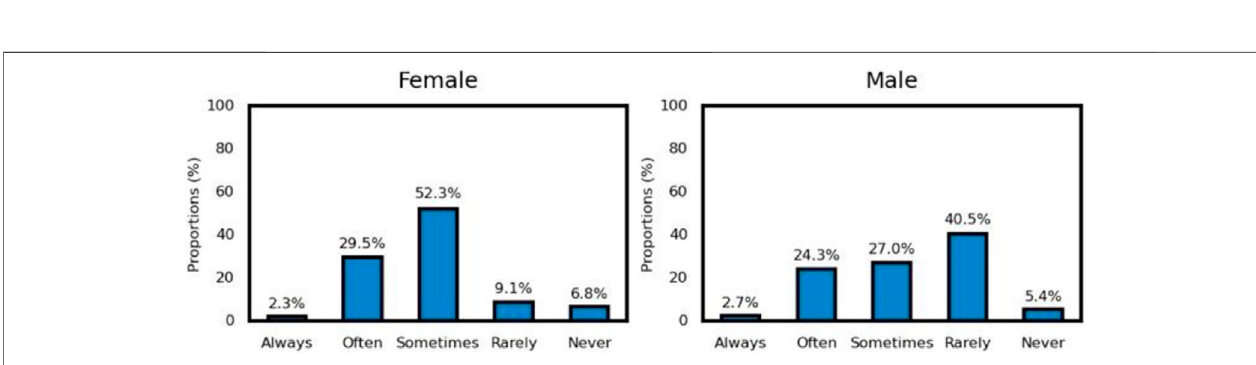
Frontiers in Energy Research |